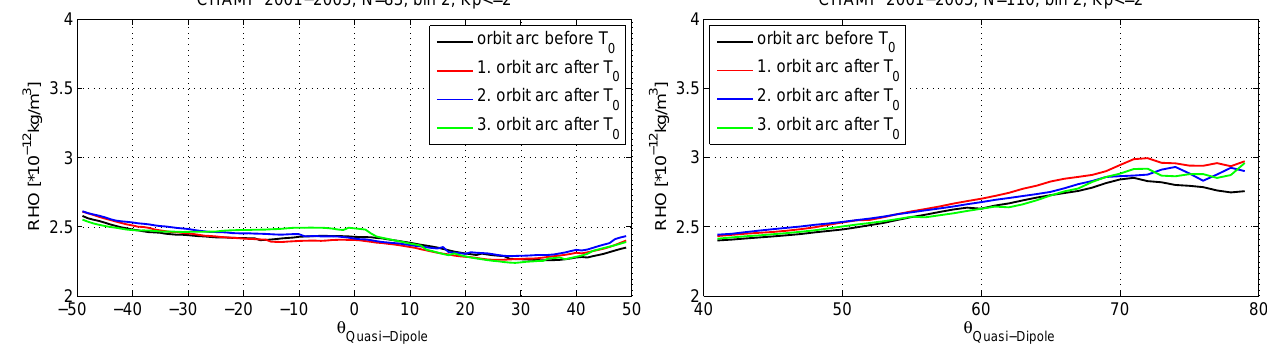
Fig. 4. same as Fig. 3, but for low magnetic activity (Kp ≤ 2). Calculated mean MLT: